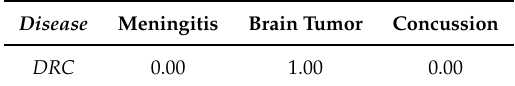
Table 2. Fusion result of Dempster’s rule of combination (DRC) given the individual beliefs presented in Table